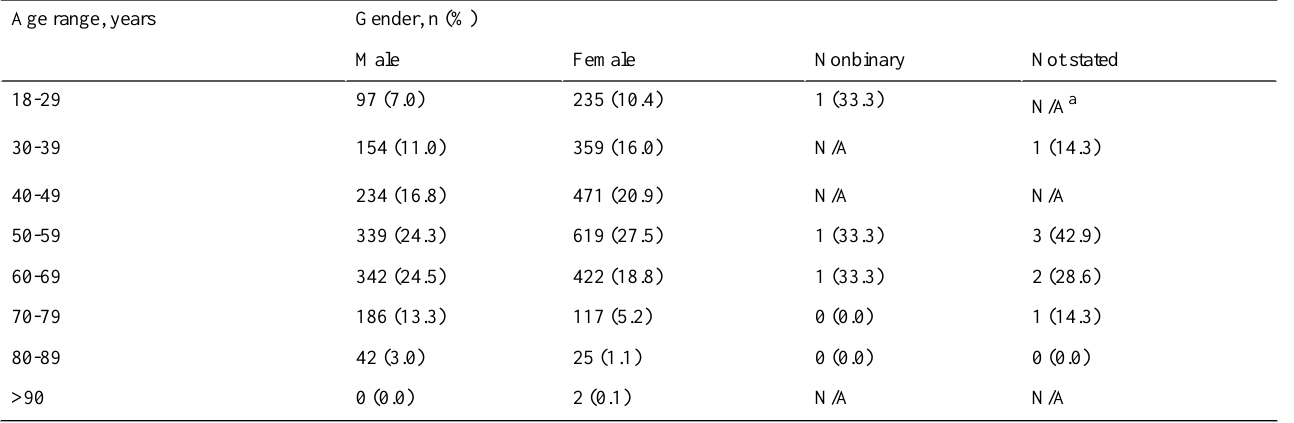
Table 1. Gender-specific age-range distribution for participants of the online survey conducted between April and July 2020. Gender, n (%)Age range,